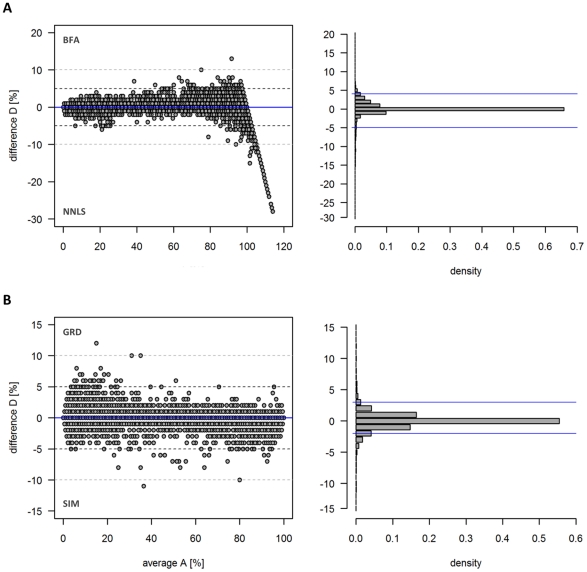
Diagnostic plots showing the differences in estimated subcellular distributions using (A) BFA and NNLS algorithm on the three independent gradients, and (B) using BFA algorithm on the three independent and 729 simulated gradients.The difference versus average plot (left) shows the differences (D) in dependence of the averages (A) of estimated subcellular distributions in a compartment (C, estimated as percentage) between two computational strategies (S): Di = Ci [S1] – Ci [S2], and Ai = 0.5 x (Ci [S1] + Ci [S2]). The corresponding computational strategies depicted in the plots are for (A) S1 = BFA and S2 = NNLS solutions, and for (B) S1 = 3 (GRD) and S2 = 729 (SIM) gradients. The histogram plot (right) shows the distribution of the M values in 1% intervals with blue solid lines indicating the 2.5% and 97.5% quantiles (95% range of observed differences). For all comparisons the average of estimated subcellular distributions (based on 3 or 729 gradients) are used.